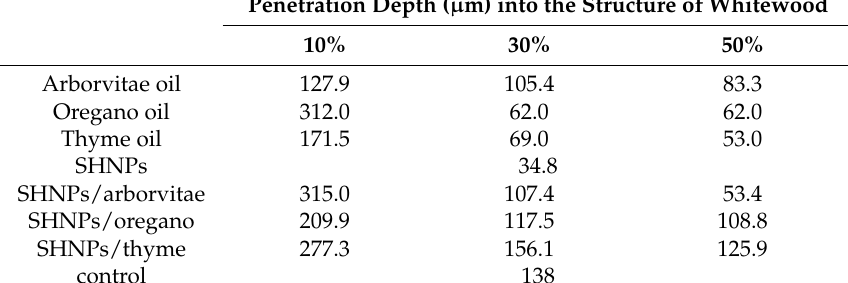
Table 4. Maximum values of fungal penetration into wood samples.